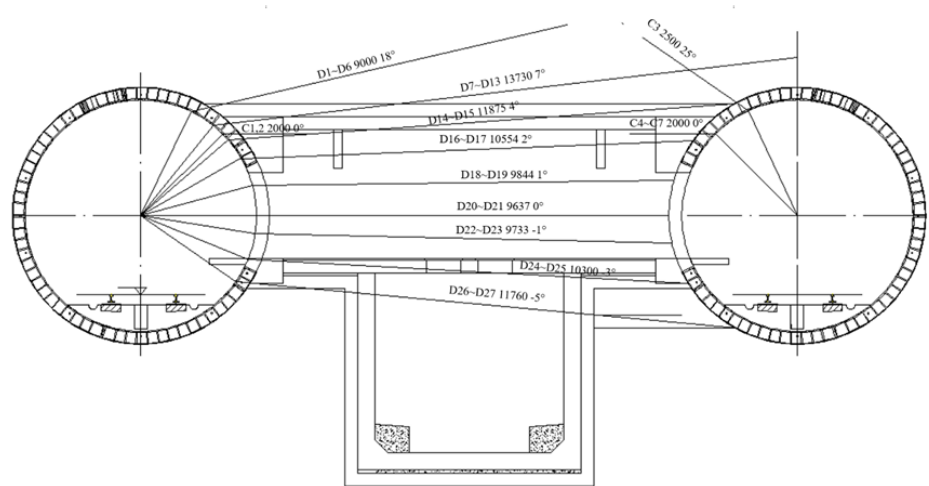
Figure 1. Elevation profile of the connecting passage (diameter of tunnel: 6.3 m; center to center distance: 15.3 m).